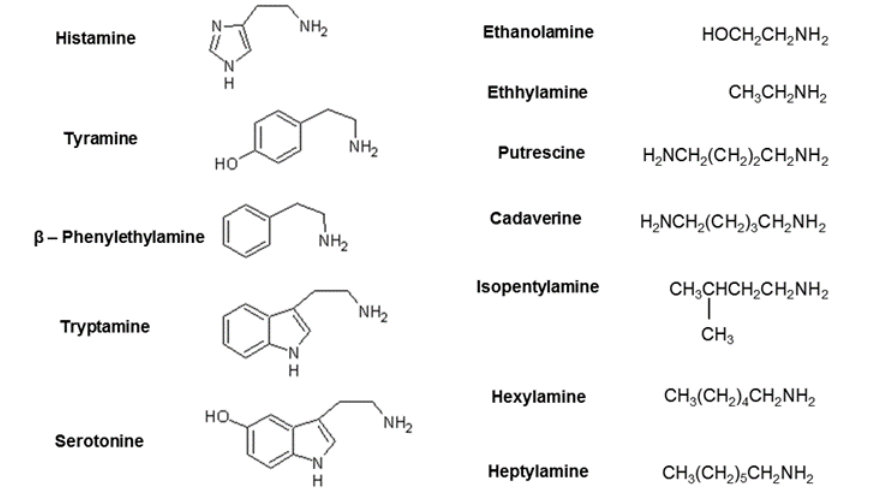
Figure 1. Biogenic amines. left : aromatic/heterocylic; righ t: aliphatic